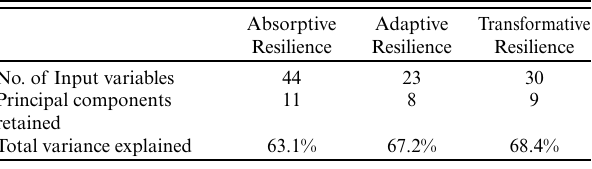
Table 2 . Overview of principal component analysis (PCA)